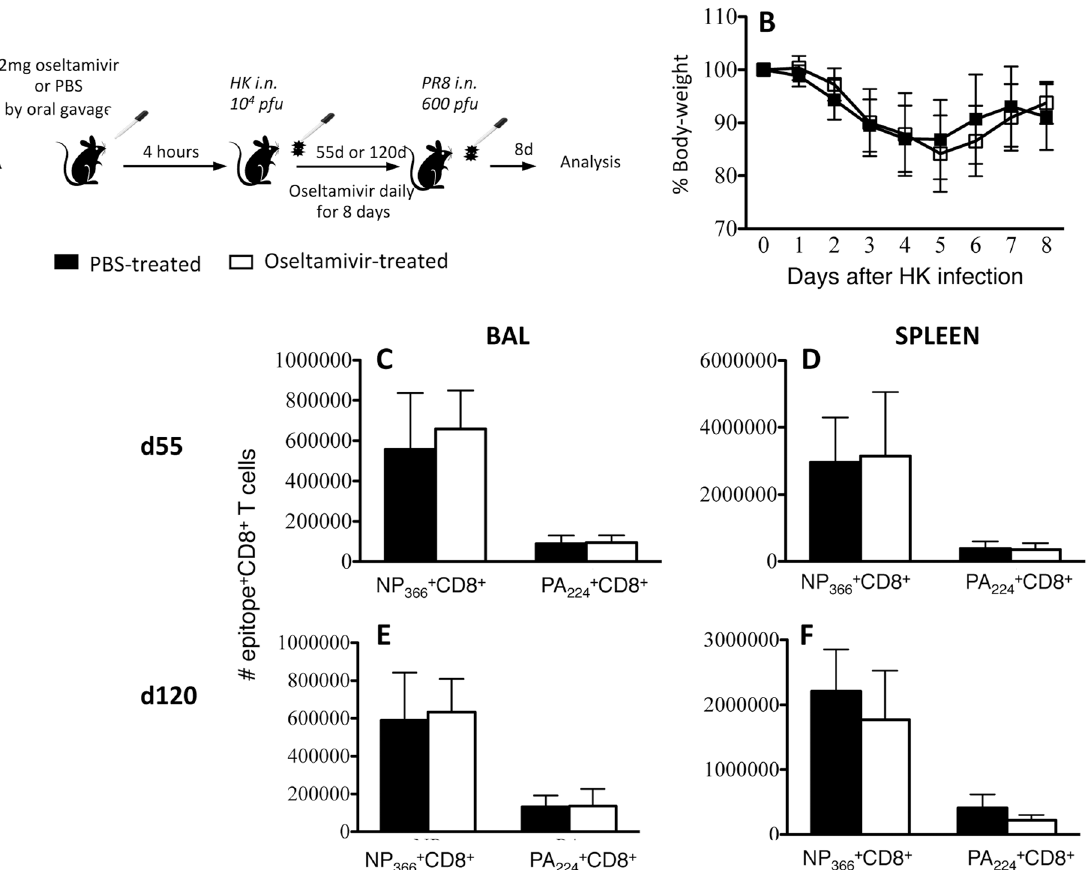
Fig 5. Recall CD8 + T cell responses are not compromised in mice with oseltamivir-interrupted primary influenza infection. (A) Na ï ve female BL/6 mice were administered either oseltamivir or PBS four hours prior to intranasal infection with 10 4 pfu of HK and then once daily for eight days. Mice were secondarily challenged i.n. with 600 pfu of PR8 either (CD) 55 or (EF) 120 days after primary infection. (B) Mice were monitored daily for body weight loss. D b NP 366 and D b PA 224 -specific CD8 + T cells in (CE) BAL and (DF) spleen were enumerated by intracellular staining of IFN- γ after five hours of stimulation with NP 366 or PA 224 peptide. Data represent the mean and standard deviation of a single experiment with 4 – 5 mice per group. Similar results were observed from two further recall experiments at day 55 after primary